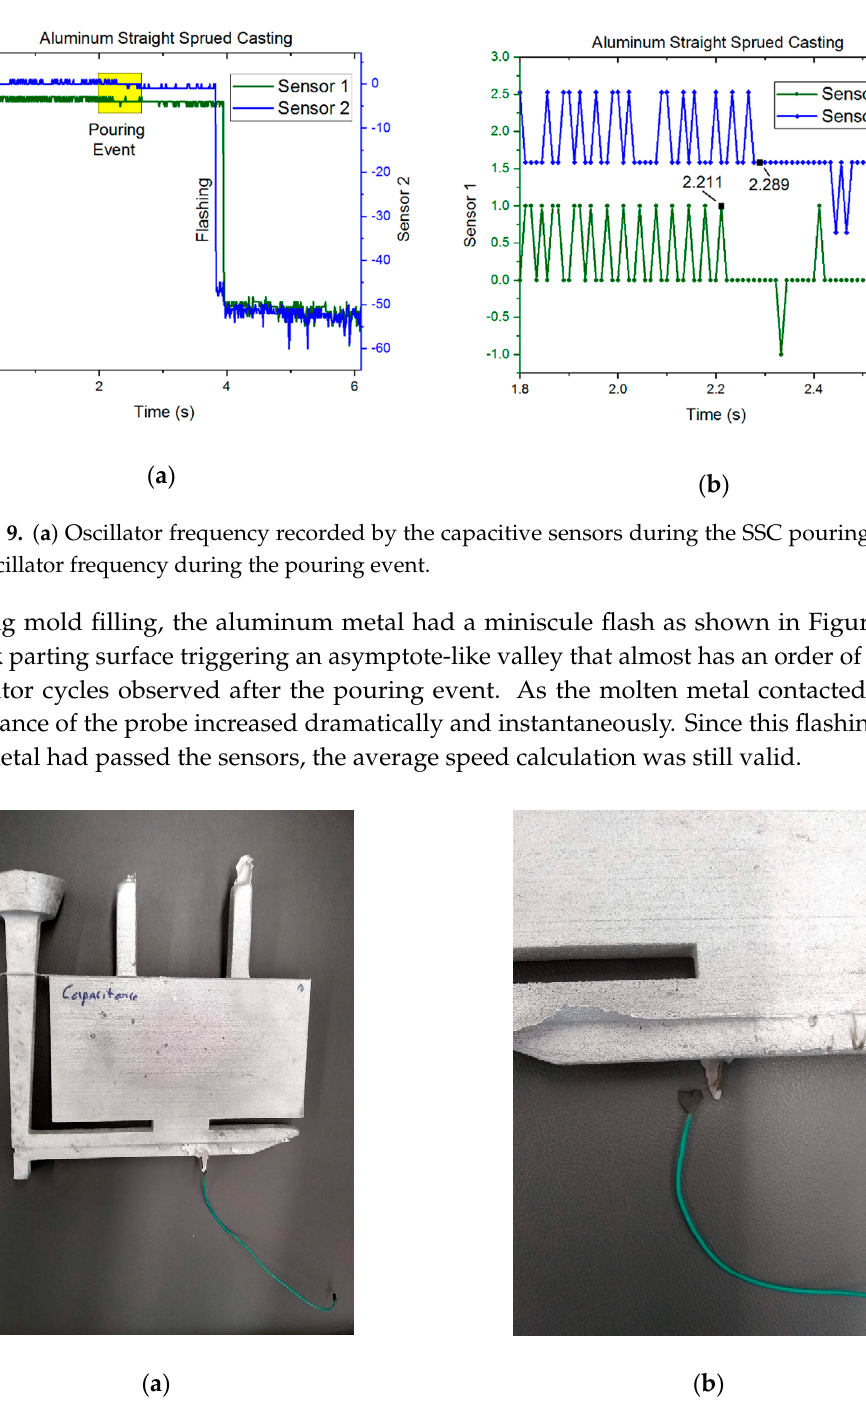
Figure 10. ( a ) Flashing occurred at the capacitive sensor. ( b ) Due to flashing, the capacitive sensor was welded onto the cast part that triggered the asymptote-like capacitance change.